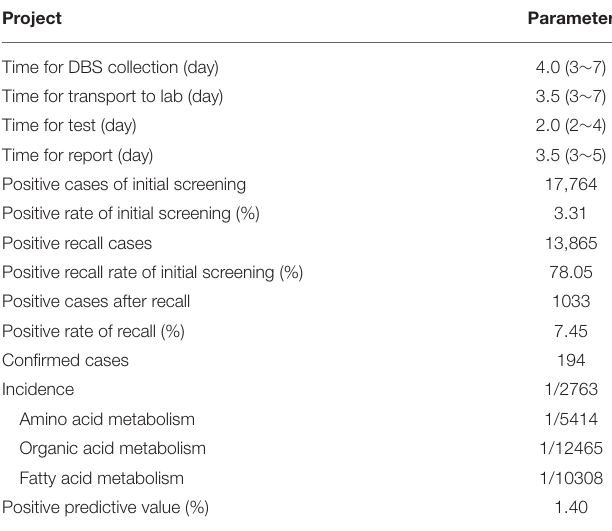
TABLE 2 | Parameters of the study project.